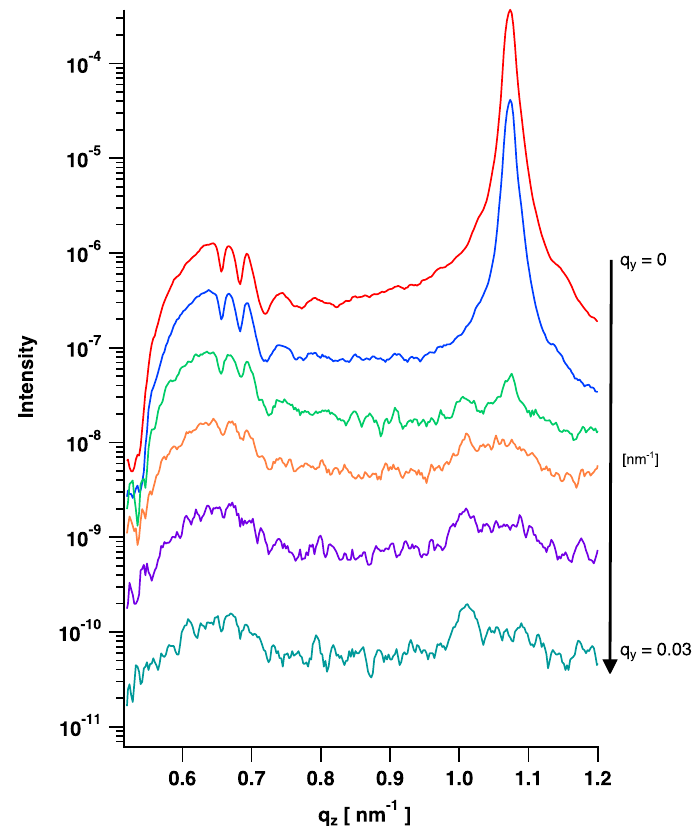
Figure 14. Line cuts in q z -direction as a function of q y , to determine the lateral cutoff length for roughness correlation of a spin-coated PS film. Intensity is plotted versus q z vector values, starting from q y = 0nm − 1 . At q y = 0.03nm − 1 modulations are no longer present, roughness is no longer correlated. Note that curves have been shifted for clarity.